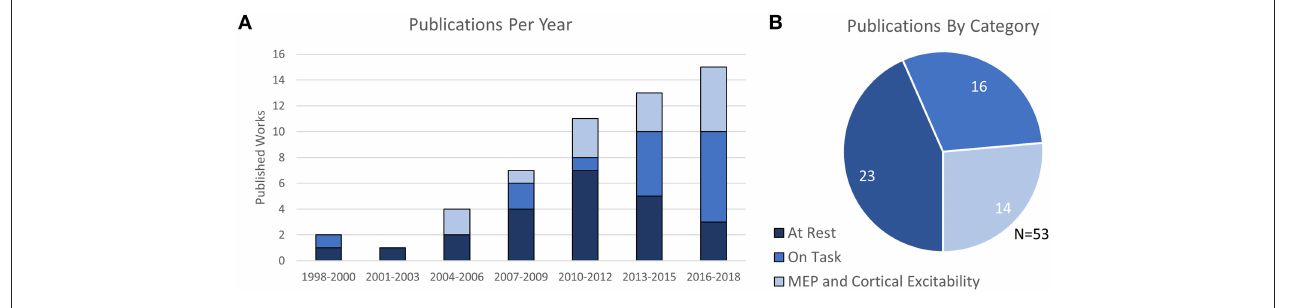
FIGURE 2 | Number and Type of TMS-fNIRS studies (A) over time and (B) as